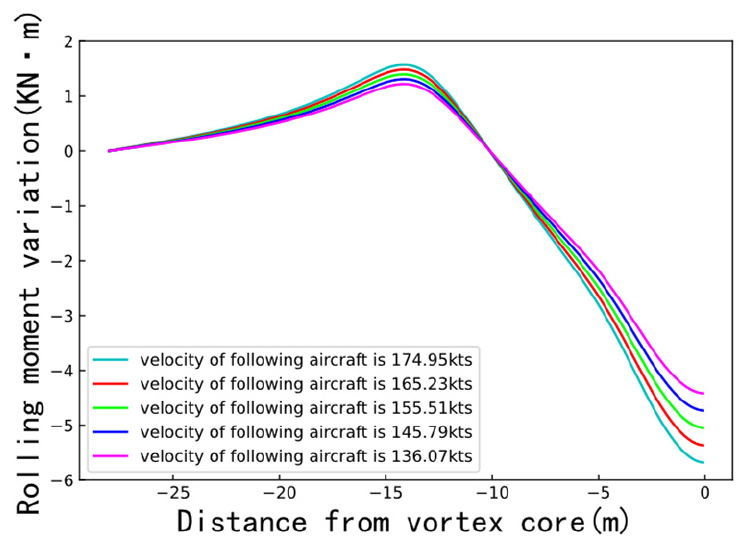
Figure 3. Rolling moment of CRJ-900 encountering wake vortex under time separation of 100 s at different velocities. (The velocity of A320 is 174.95 kts, and the counter-clockwise rolling moment is negative).